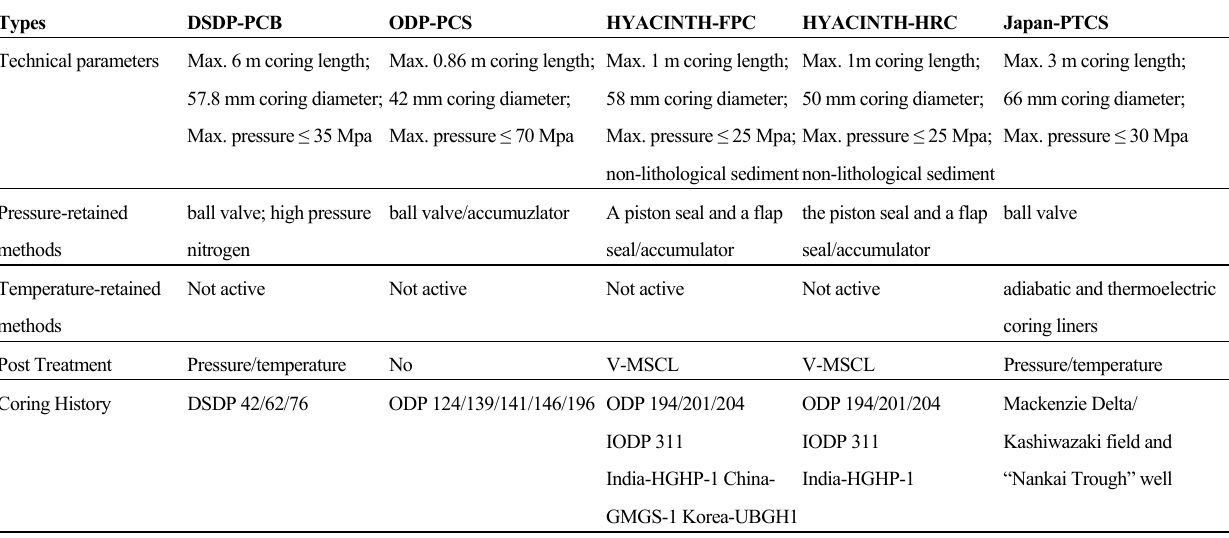
Table 1. Current service conditions of major pressure-retained